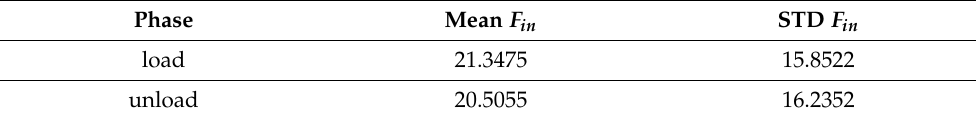
Table 3. E-skin sensors insensitivity threshold F in statistics.